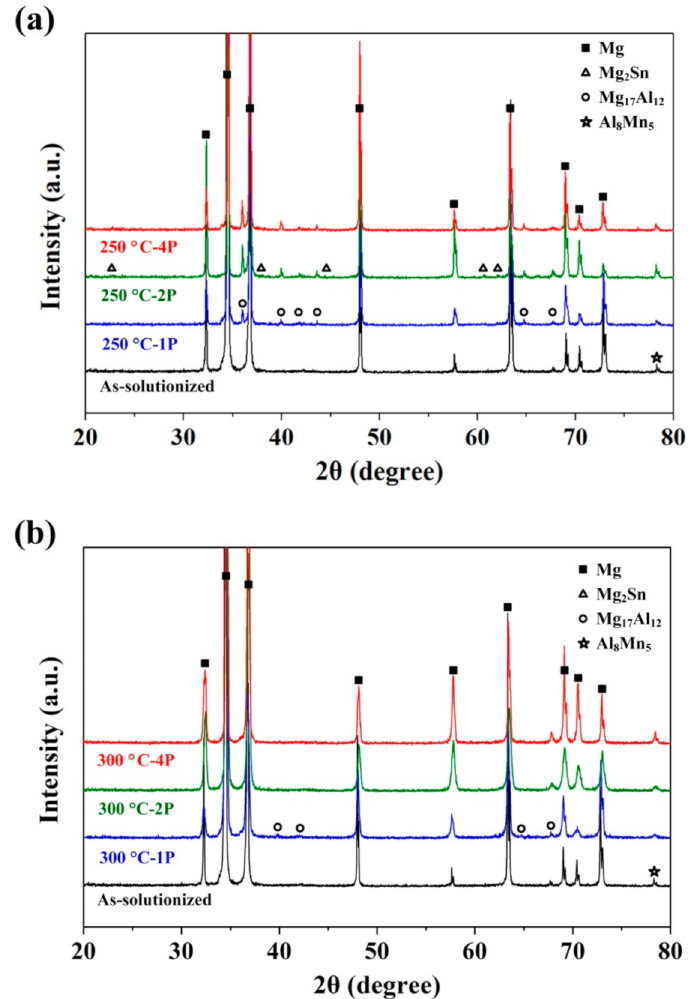
Figure 4. XRD results of the as-solutionized and the 250 ◦ C and 300 ◦ C ECAP samples. ( a ) 1 pass,